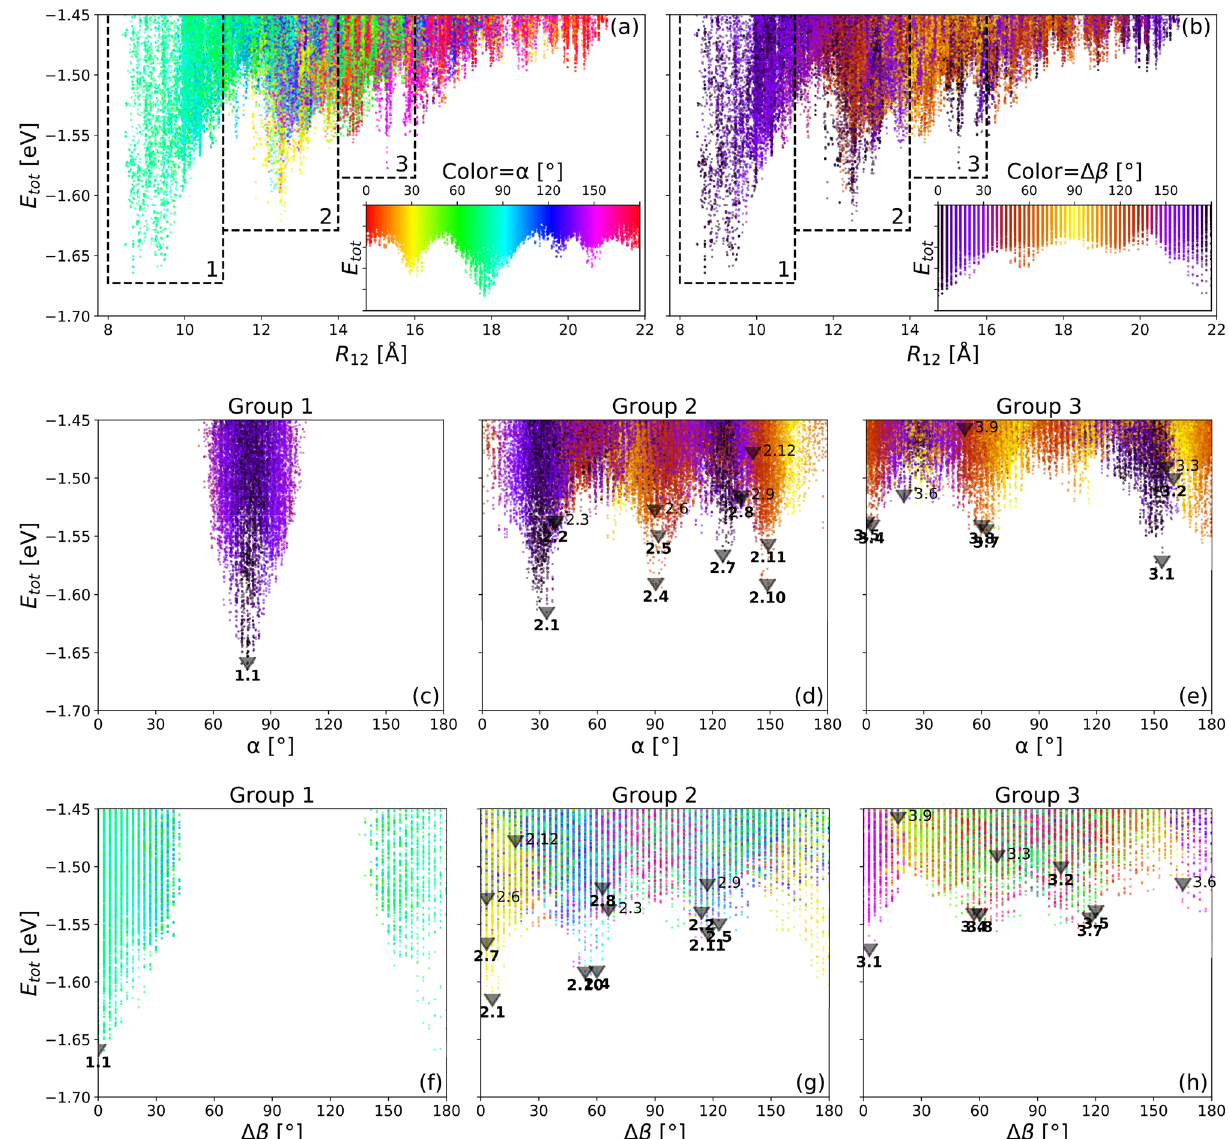
Figure 4. ( a , b ): Total energy E tot for pair configurations over distance R 12 . The color maps show the position of one molecule relative to the other described by the angle α enclosed by one molecular backbone and the connection line, and the relative orientation angle �β between the molecules, respectively. The insets show the colorscales for the angles as E tot (α) and E tot (�β) plots. The insets reflect intrinsic symmetries of the system ◦ ◦ which are invariance against a rotation by 180 in α , panel (a), and mirror symmetry around �β = 0 and 90 ◦ , panel ( b ). The marked y -values in the insets are the same as in the main figure. Dashed frames mark the regions around the main peaks selected as distance groups for further analysis. ( c - e ): Total energy E tot for pair configurations over α . Each panel shows configurations from one distance group. The labeled triangles indicate the positions of sampled configurations for each visible peak. The colors correspond to the relative orientation of the molecules by angle �β , see panel ( b ) for the color key. ( f - h ): Total energy E tot for pair configurations over the relative orientation angle �β of the molecular backbones. Each panel shows configurations from one distance group only. The labeled triangles indicate the positions of sampled configurations for each visible peak. The colors correspond to the angle α , see panel ( a ) for the color In Group 1, there is only one symmetrically unique minimum state, labelled 1.1, representing a configuration ◦ in which the molecules are parallel and only slightly offset ( α ≈ 80 ) at a distance of about 9Å . We denote this configuration normal fence . A prototype is shown in Fig. 5a. In Group 2, corresponding to larger distances of about 12.5Å between the centers, the normal fence configu- ration is no longer favorable. The minimum energy configuration, although still a parallel one, is strongly offset ◦ at α ≈ 33.7 as indicated by the label 2.1. This configuration is shown as prototype in Fig. 5b and we denote it as hunter’s fence A . The runner-up configurations 2.2 and 2.3 could be considered marginal as they are close to